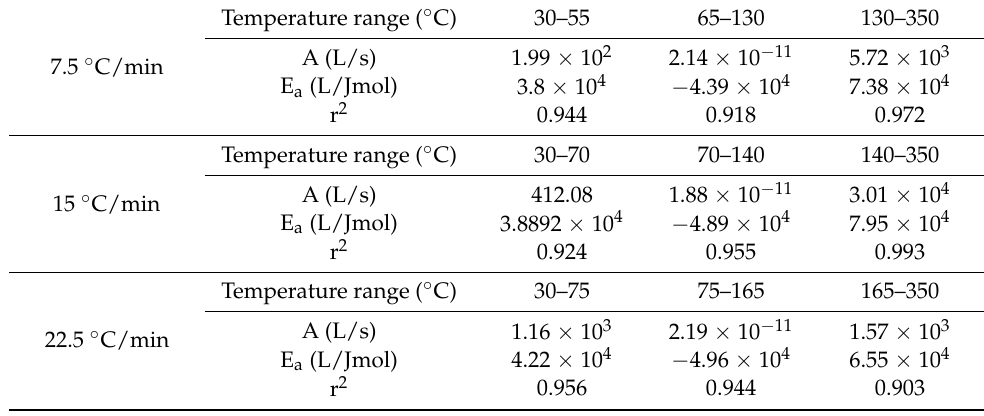
Figure 10. Regression lines of characteristic temperature for grape branch ( a ) and perilla ( b ) at a heating rate of 7.5 ◦ C/min. Table 6. Frequency factor and activation energy of perilla from TGA results. Table 5. Frequency factor and activation energy of grape branch from TGA